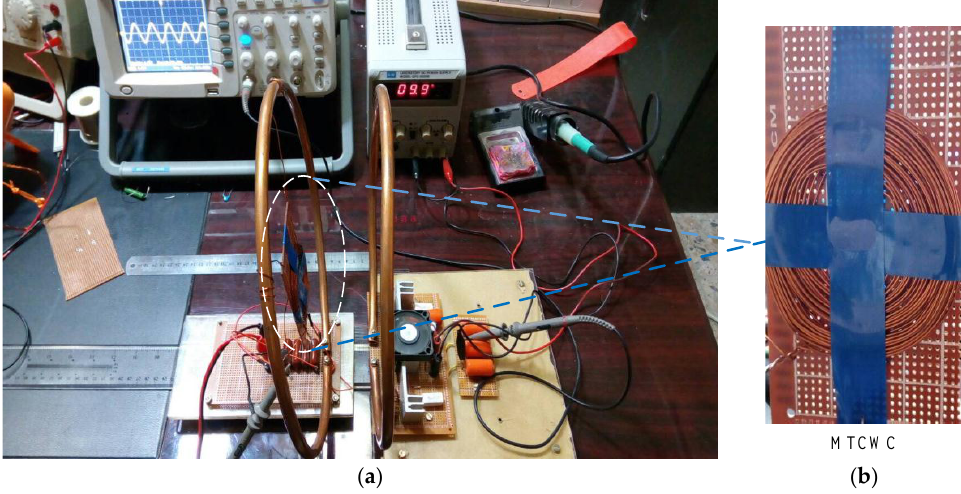
Figure 7. Experiment topology of MTCWC of ( a ) the adopted experiment and ( b ) MTCWC circuit.